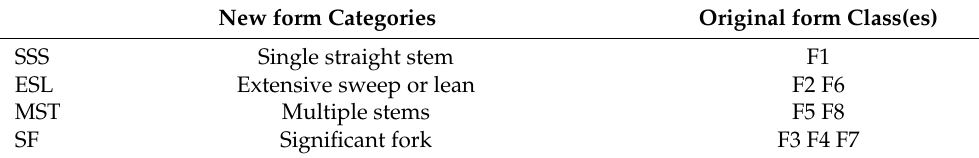
Table 5. Form categories built from form